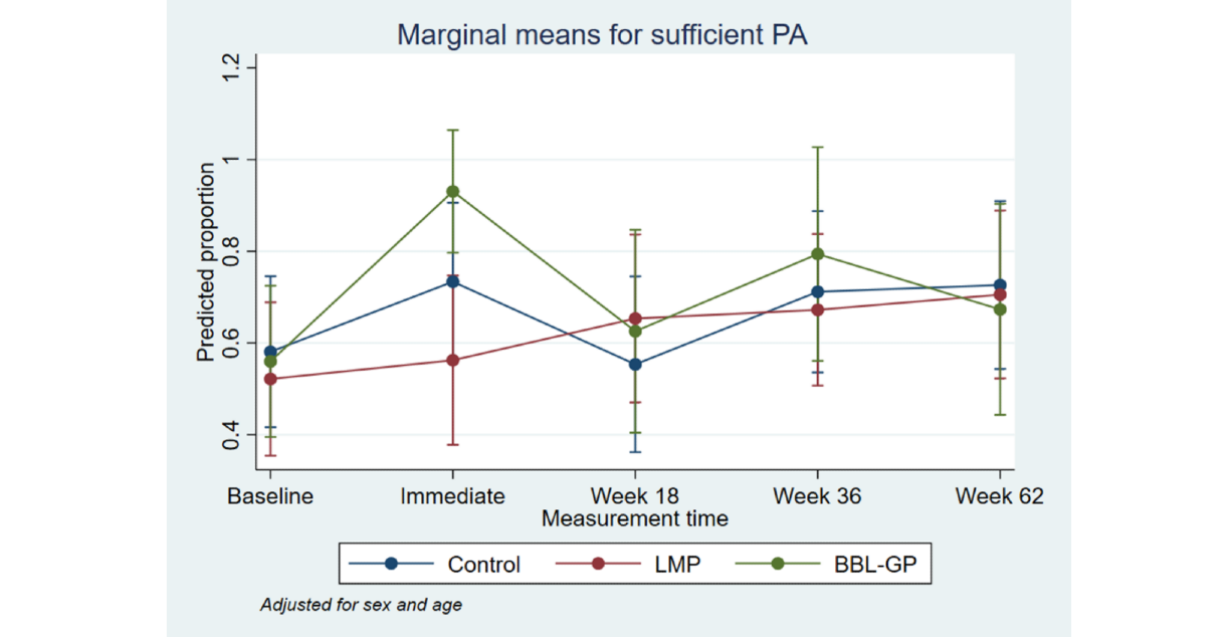
Figure 5. Proportion with sufficient physical activity with 95% CI, by time point and intervention group. Although the upper limit of some 95% CIs has been estimated as >1, it is not possible for a proportion to exceed 1. BBL-GP: Body Brain Life in General Practice; LMP: Lifestyle Modification Program; PA: physical